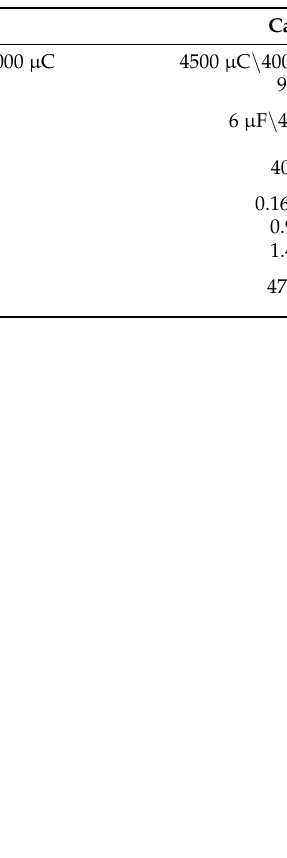
Table 2. Parameters of series diodes.